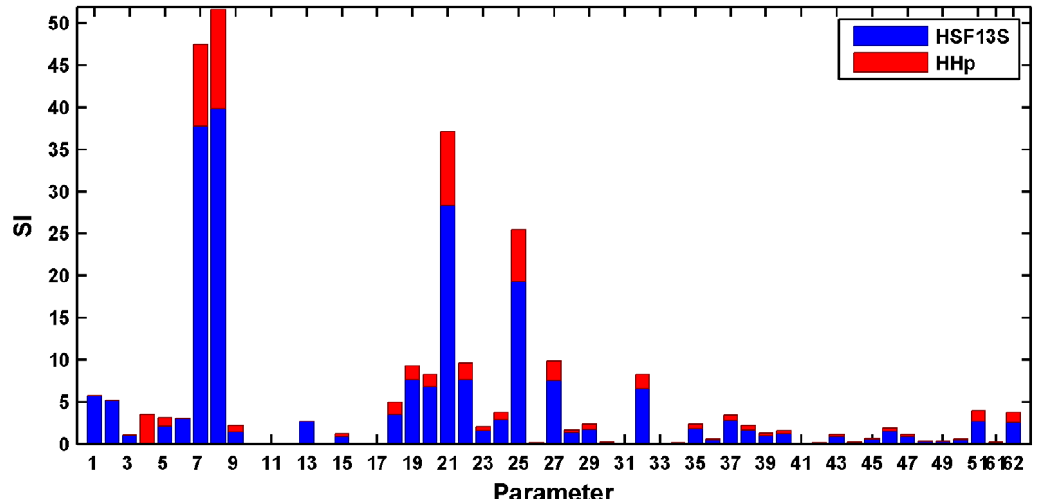
Figure 5. Local relative sensitivity analysis for the estimated parameters. The bars show in blue the sensitivity due to the effect of the parameters on HSF13S and in red the corresponding to HHp. As expected, there are several parameters having very little influence on the measured states, therefore, the parameter values obtained from the global optimization have to be taken with caution. Most of the parameters that appear insensitive in this analysis are sensitive to other species, thus experimental data of these intermediate states would help to better estimate these values. The numbers on the abscissa corresponds to the kinetic constants given in Table 1.